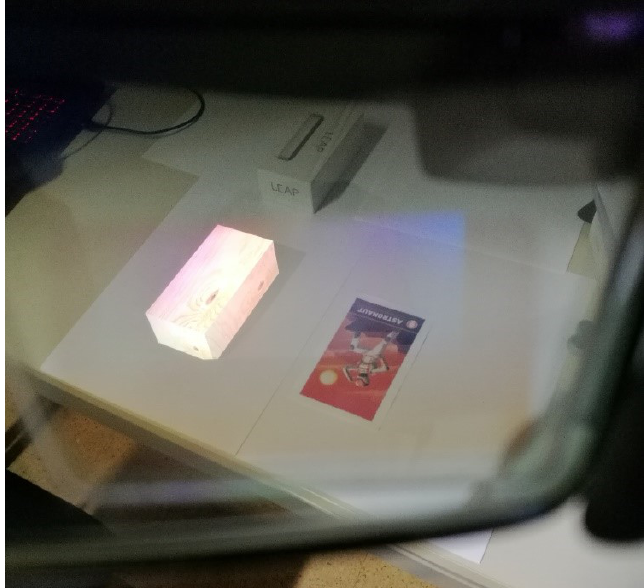
Figure 24. HoloLens shadow